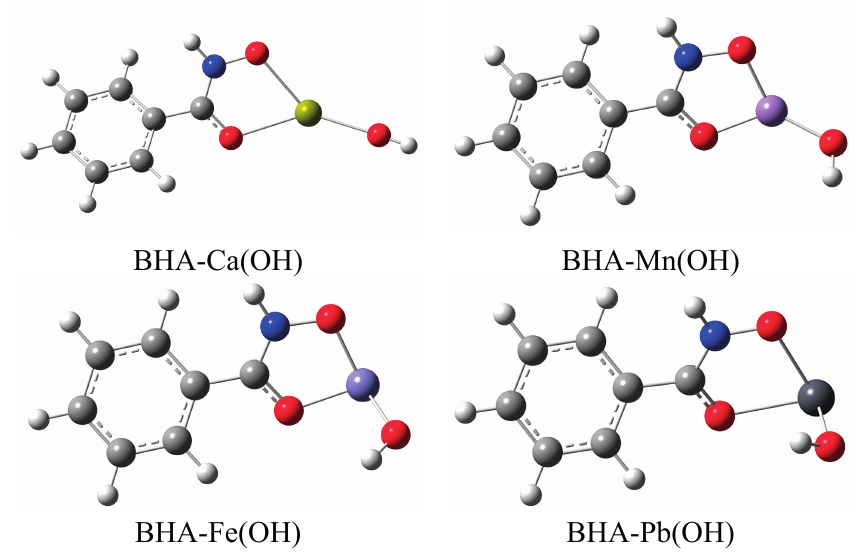
Figure 9. The optimized geometries of the coordination compounds of BHA anion with Ca(OH) + , Mn(OH) + , Fe(OH) + and Pb(OH) +